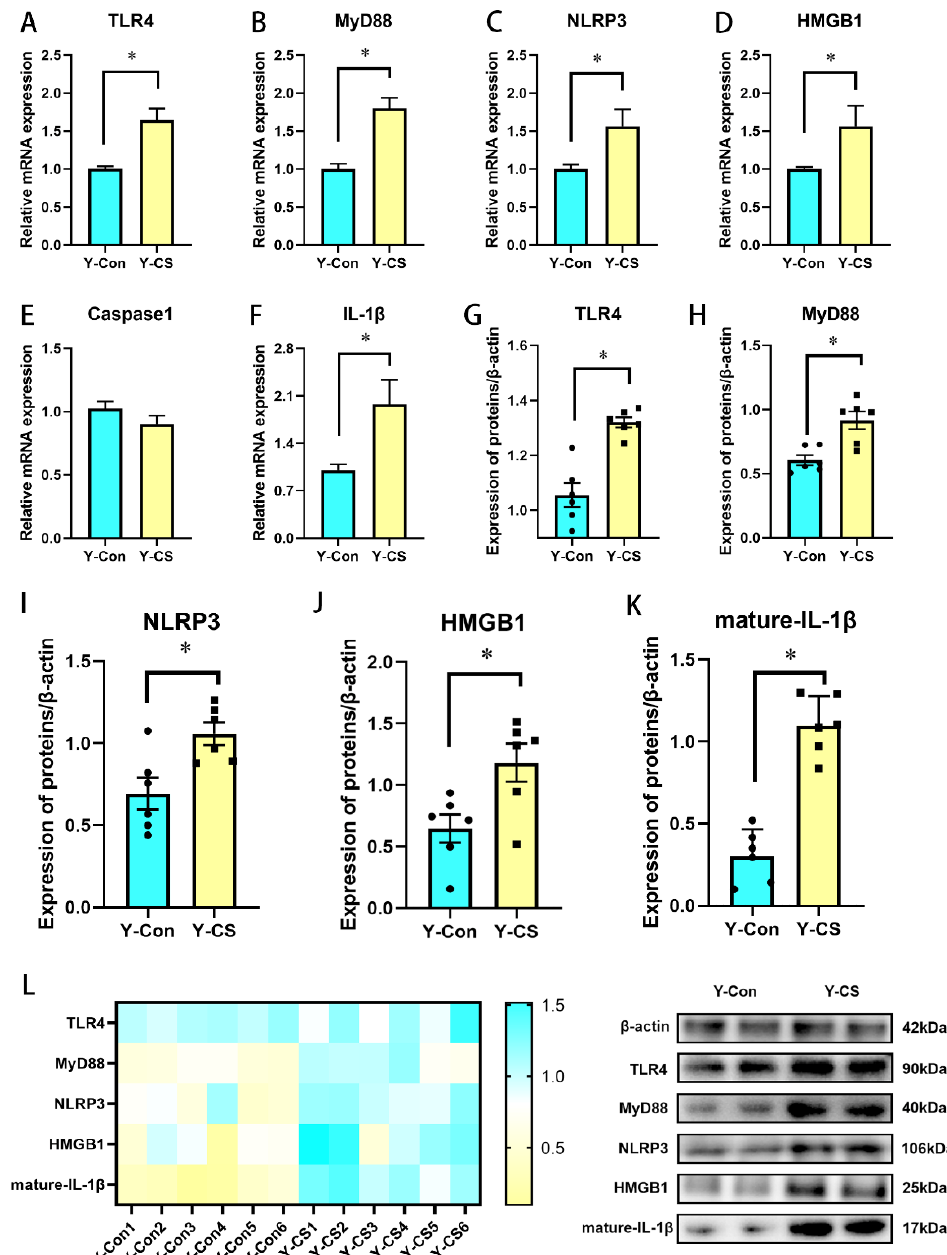
Figure 2. Chronic cold exposure promotes inflammatory pathways in lung tissue. ( A ) Toll-like receptor 4 (TLR4) mRNA expression. ( B ) Myeloid differentiation main response 88 (MyD88) mRNA expression. ( C ) Nucleotide-binding domain and leucine-rich repeat protein 3 (NLRP3) mRNA expression. ( D ) High mobility group box 1 (HMGB1) mRNA expression. ( E ) Caspase1 mRNA expression. ( F ) IL-1 β mRNA expression. ( G ) TLR4 protein expression. ( H ) MyD88 protein expression. ( I ) NLRP3 protein expression. ( J ) HMGB1 protein expression. ( K ) Mature-IL-1 β protein expression. ( L ) Heat map of protein expression levels. Data are expressed as the mean ± SEM, n = 6, * p < 0.05.